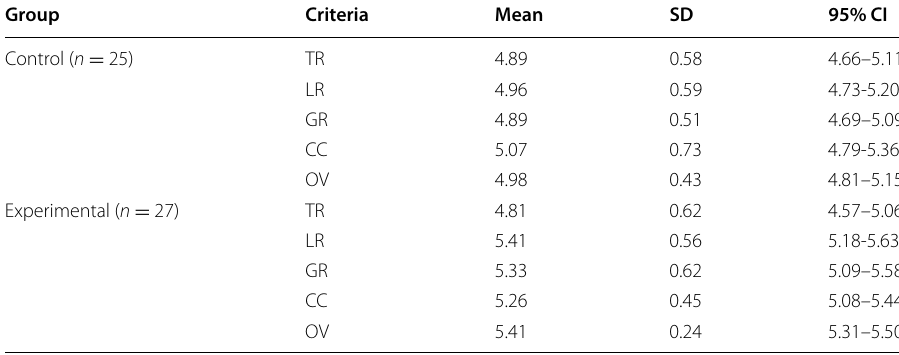
Table 5 Descriptive statistics for the posttest Group